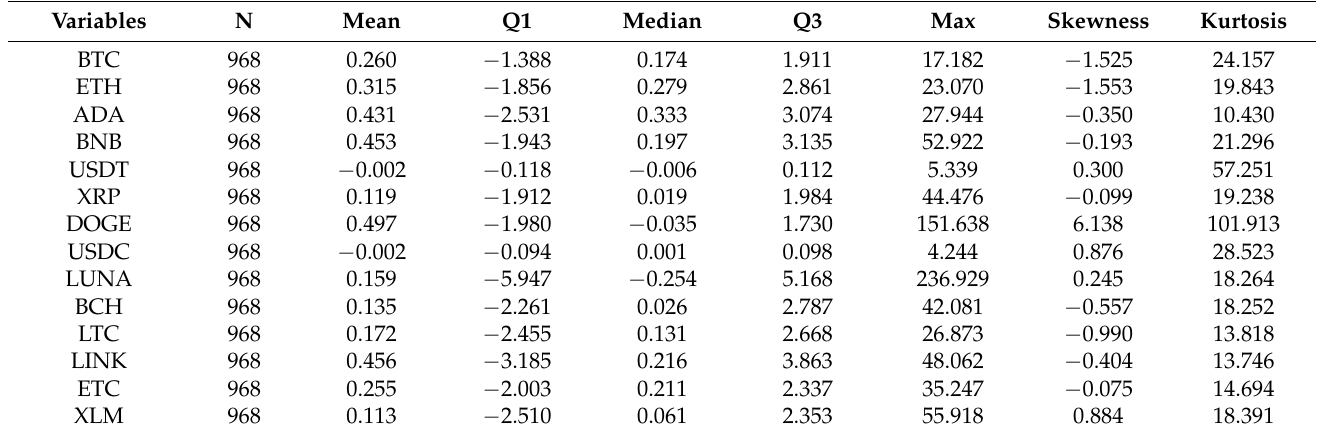
Table 2. Summary